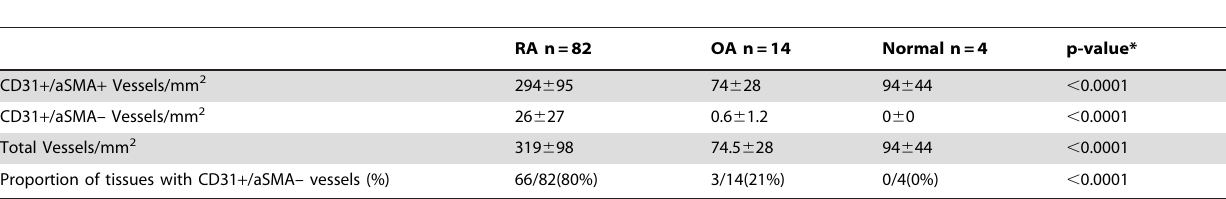
Table 1. Mature and Immature Vessels in RA, OA or Normal Synovial